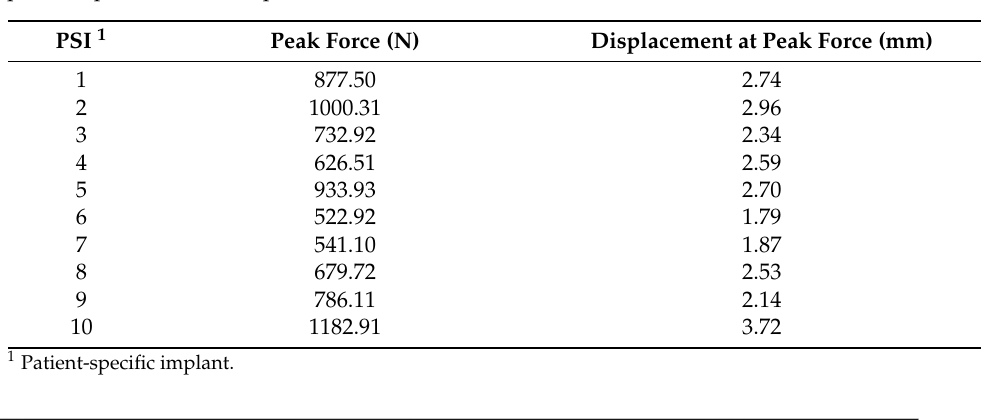
Table 3. Peak force (N) vs. displacement at peak force (mm) in material extrusion 3D-printed PEEK